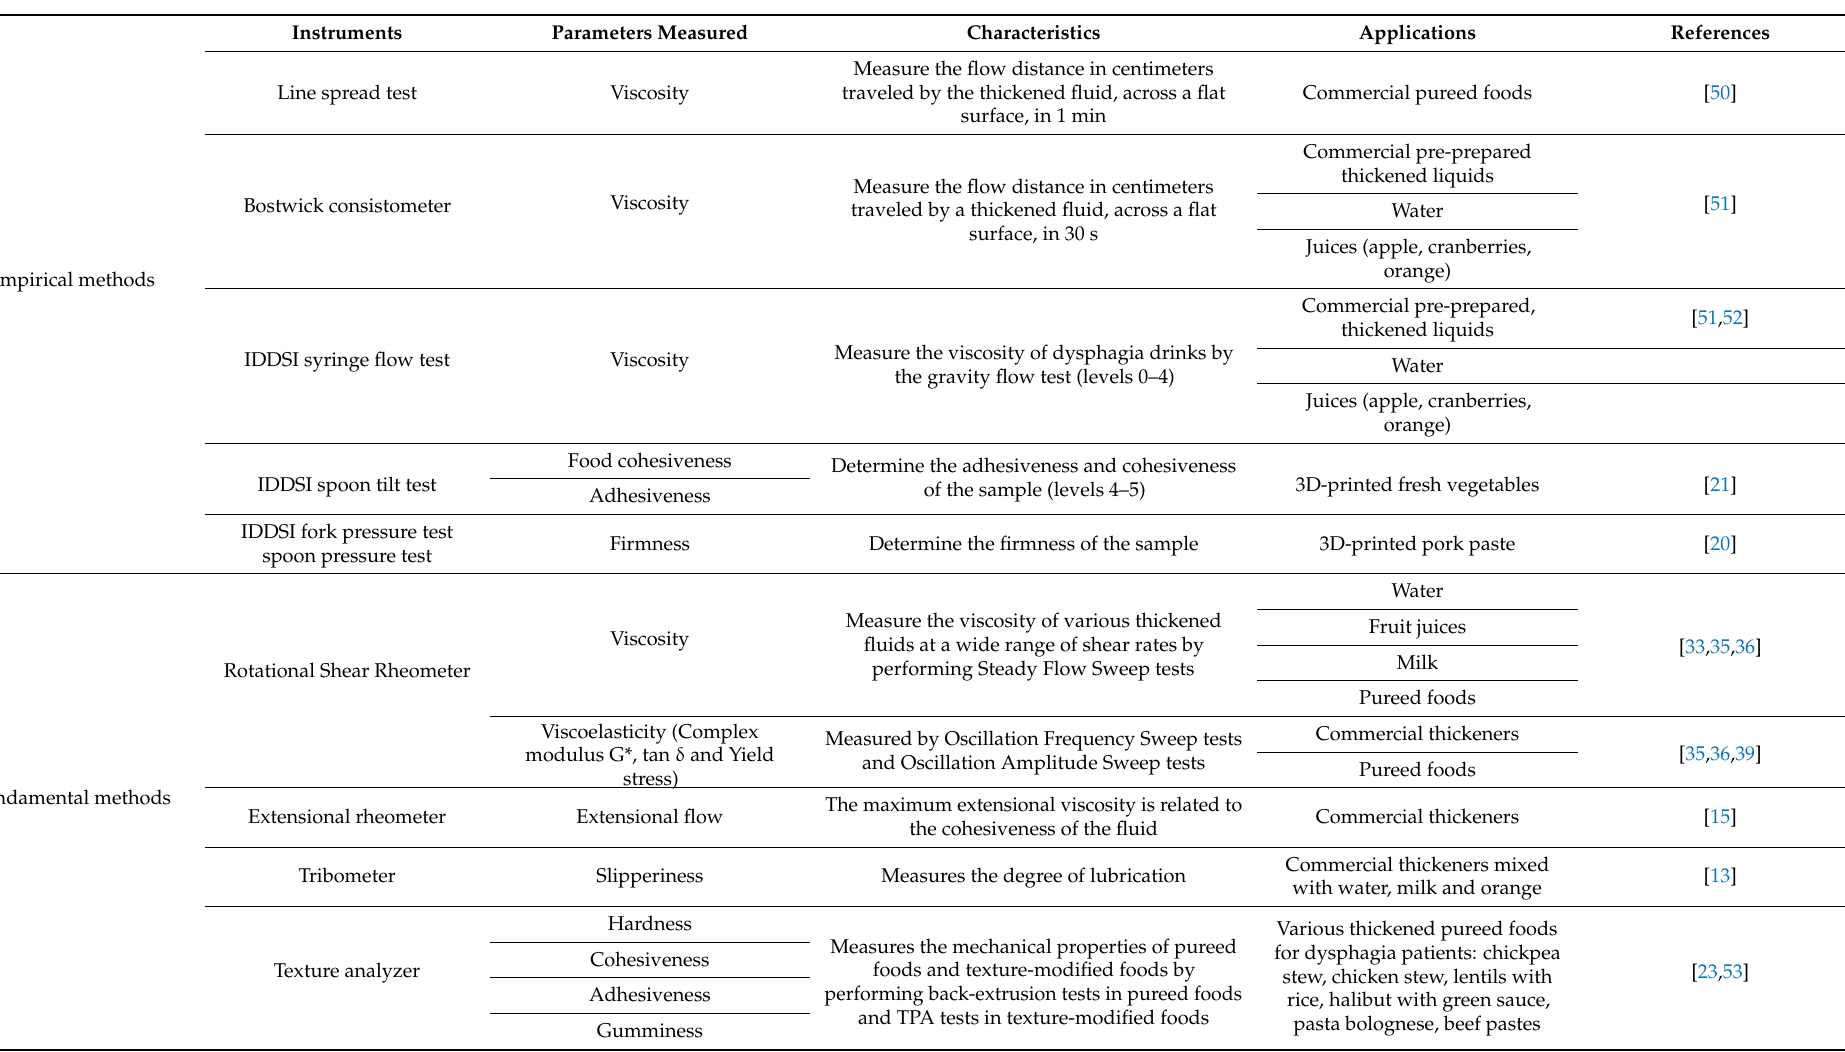
Table 1. Summary of the available methods and instruments that have been used in the last few years to characterize dysphagia